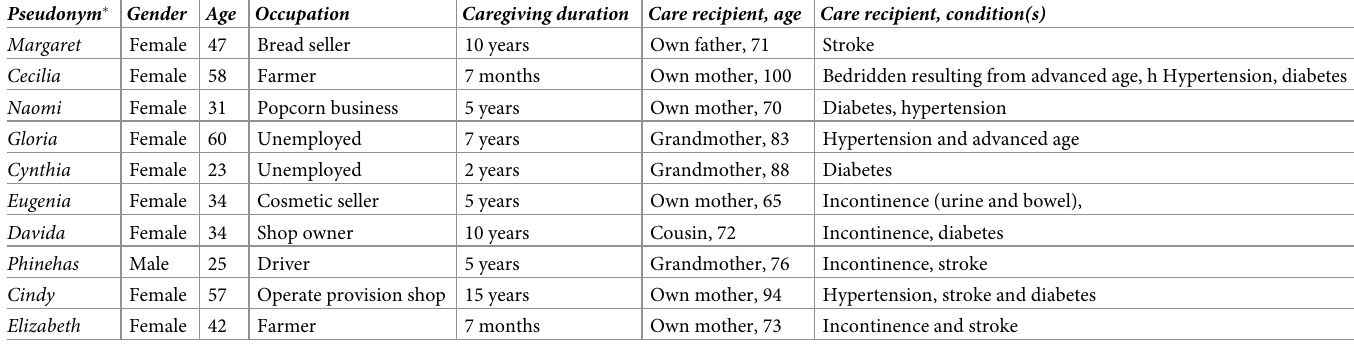
Table 1. Demographic information of family